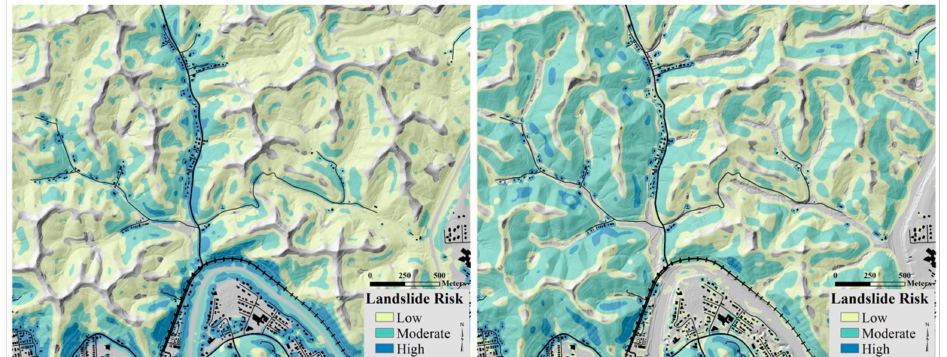
Figure 15. Comparison of the susceptibility-based map ( left ) and slope-based map ( right ) in popu- lated part of Johnson County. Relatively large population differences in block group-based population create over prediction of risk at the block-group boundaries ( right